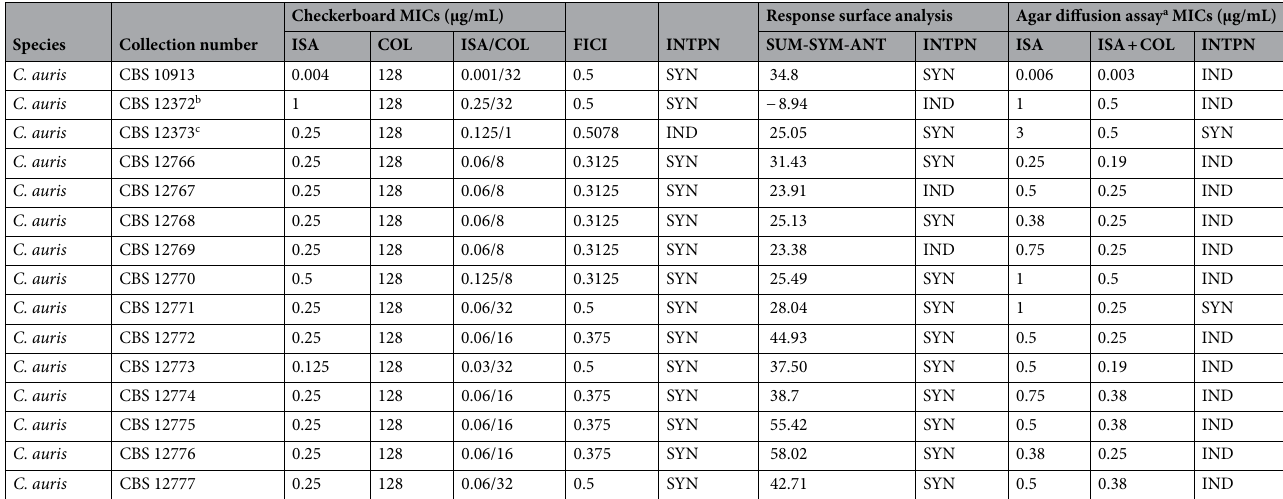
Table 1. Interaction of isavuconazole with colistin against Candida auris by checkerboard and interpretation by fractional inhibitory concentration index, response surface analysis and by agar diffusion. FICI, fractional inhibitory concentration index; INTPN, interpretation; SYN, synergy; IND, no interaction; ISA, isavuconazole; COL, colistin; CBS, Westerdijk Fungal Biodiversity Institute. a Colistin alone at 64 µg/mL incorporated in the RMPI agar did not inhibit the growth of any of the isolates. b Other collection number: KCTC 17809. c Other collection number: KCTC 17810.